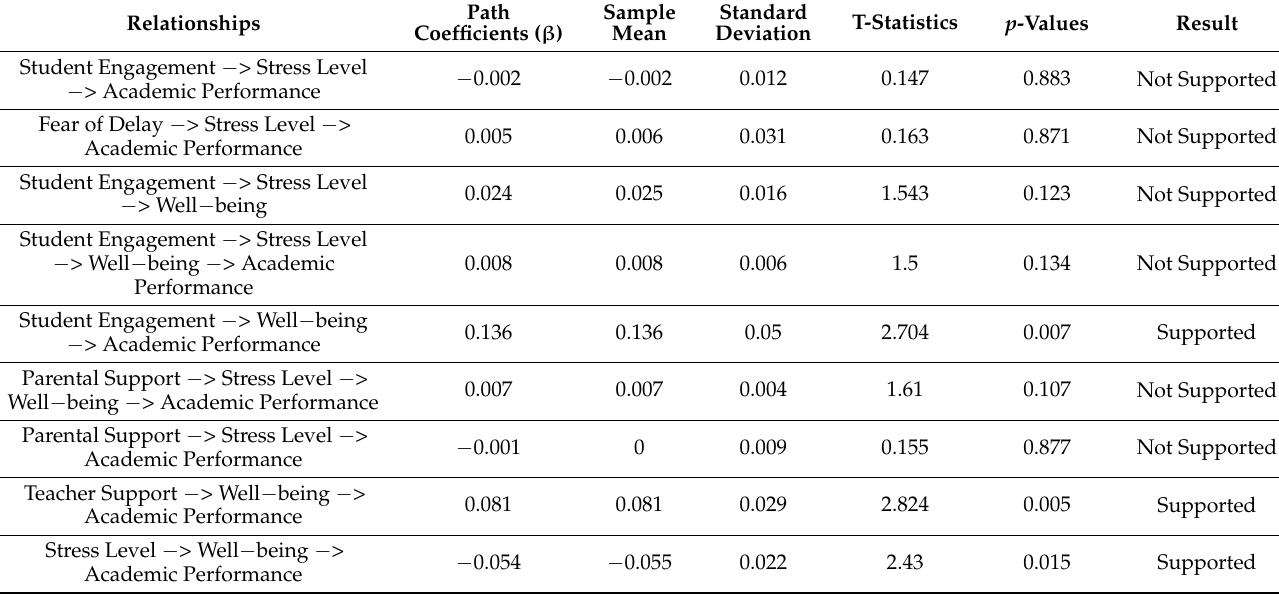
Table 8. Results of indirect effect